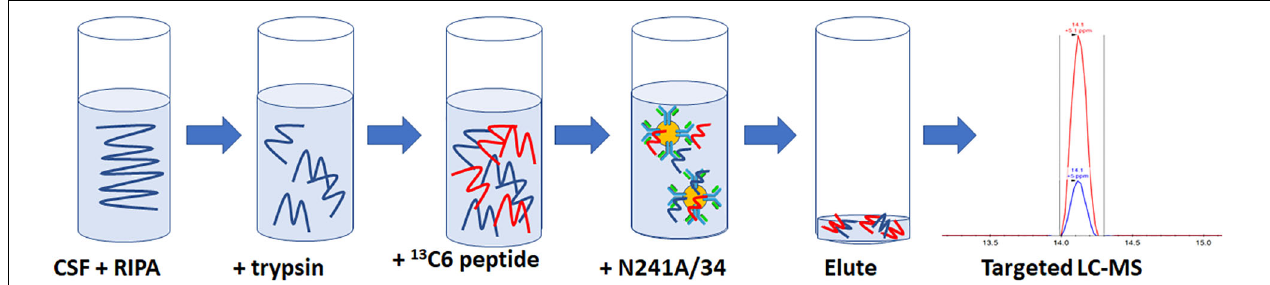
FIGURE 1 | Schematic representation of the SISCAPA workflow used here to detect total LRRK2 levels. CSF is incubated with RIPA buffer and trypsin for 1.5 h at 40C. Samples are put on ice for 5 min and then two pg of heavy labeled 136C15N4 KAEEGDLLVNPDQPR is spiked into the sample. Biotinylated N241A/34 conjugated to M280 streptavidin beads are added to samples to isolate both heavy and light KAEEGDLLVNPDQPR peptides. Beads are washed and eluted. Analysis of light:heavy ratio is done using nanoflow LC and orbitrap mass